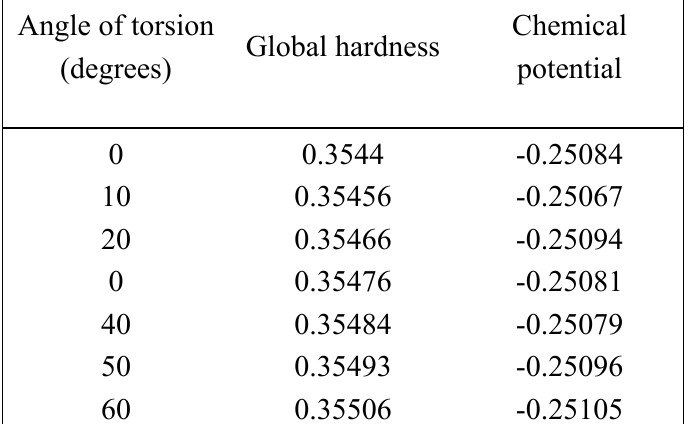
B-NH system as 3 3